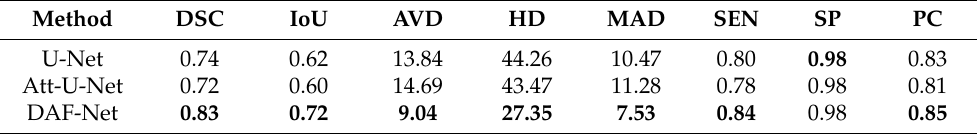
Table 2. Summary of network performance evaluation (Bold font indicates best result obtained).